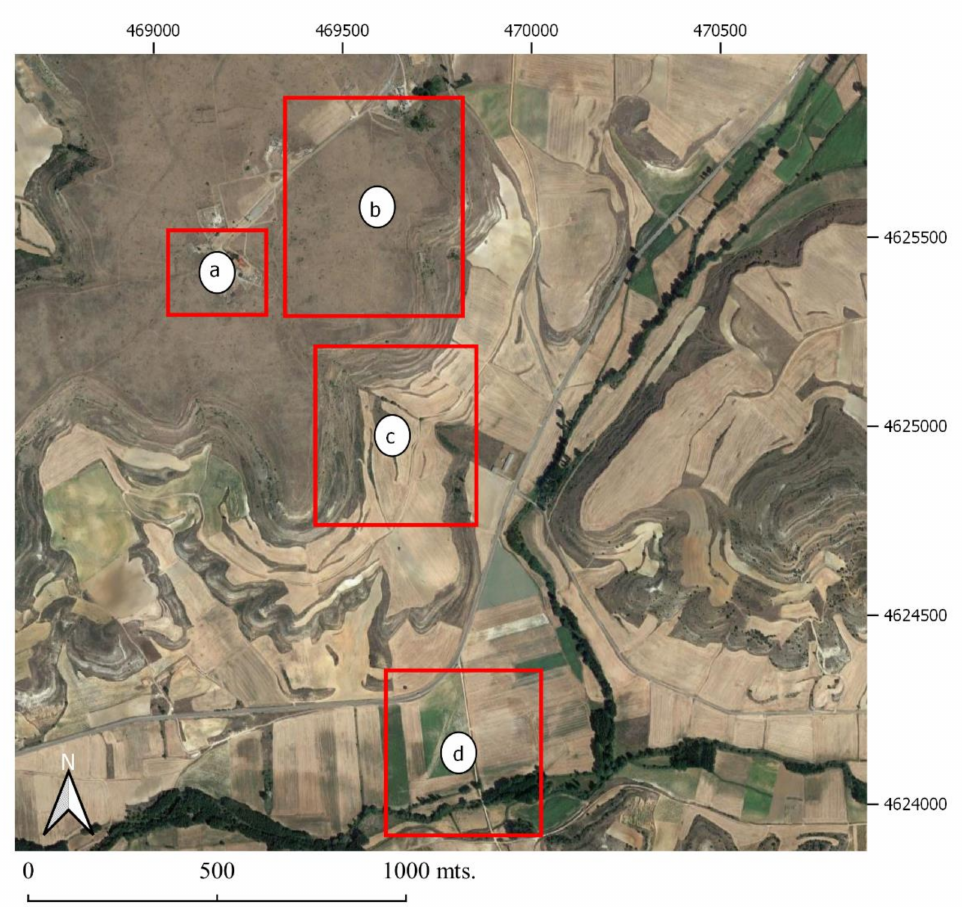
Figure 4. Areas explored with the results of analyzing the SAR images of PAZ. ( a ) Clunia forum . ( b ) Forum –theatre–Cuevas Ciegas area. ( c ) Cuevas Ciegas. ( d ) Rodeles II. Source: Google satellite